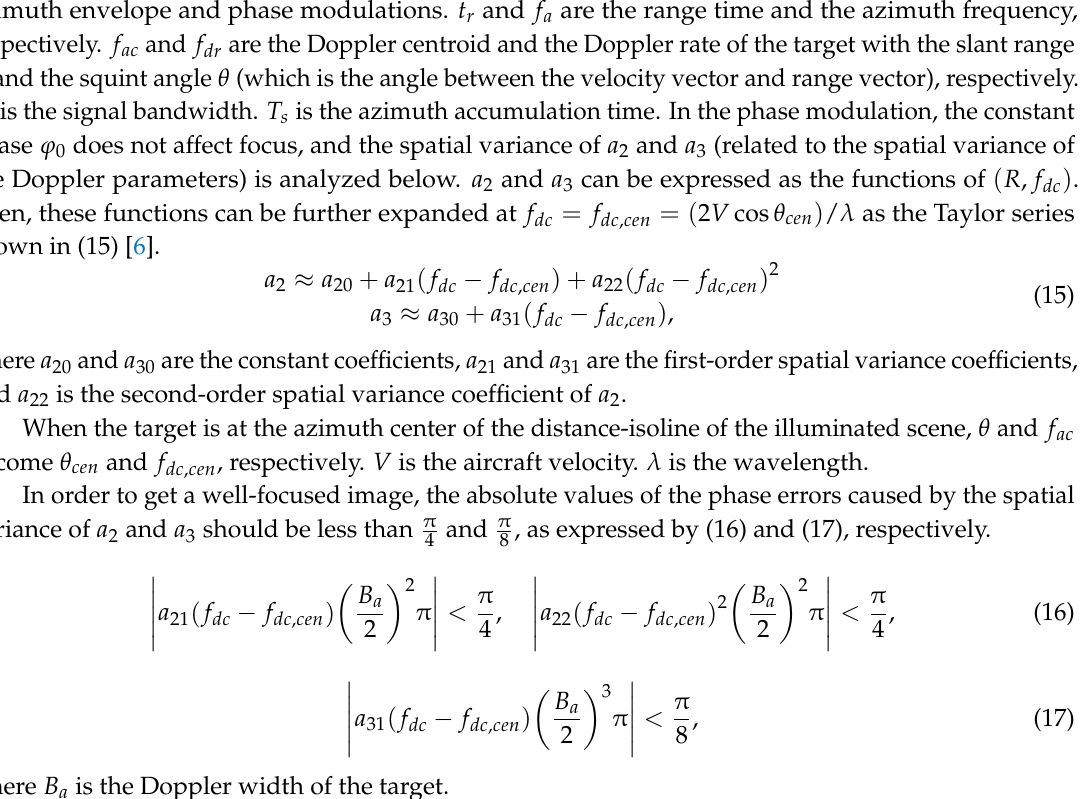
Figure 7. The spatially-variant phase errors caused by the spatially-variant Doppler parameters. ( a ) The phase error caused by the Doppler rate; ( b ) the phase error caused by the derivative of the Doppler